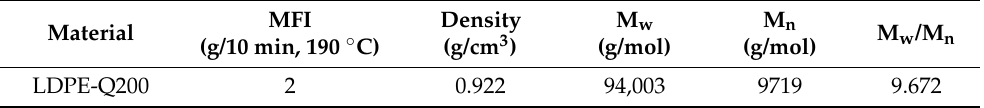
Table 1. Basic characteristics of the sample.